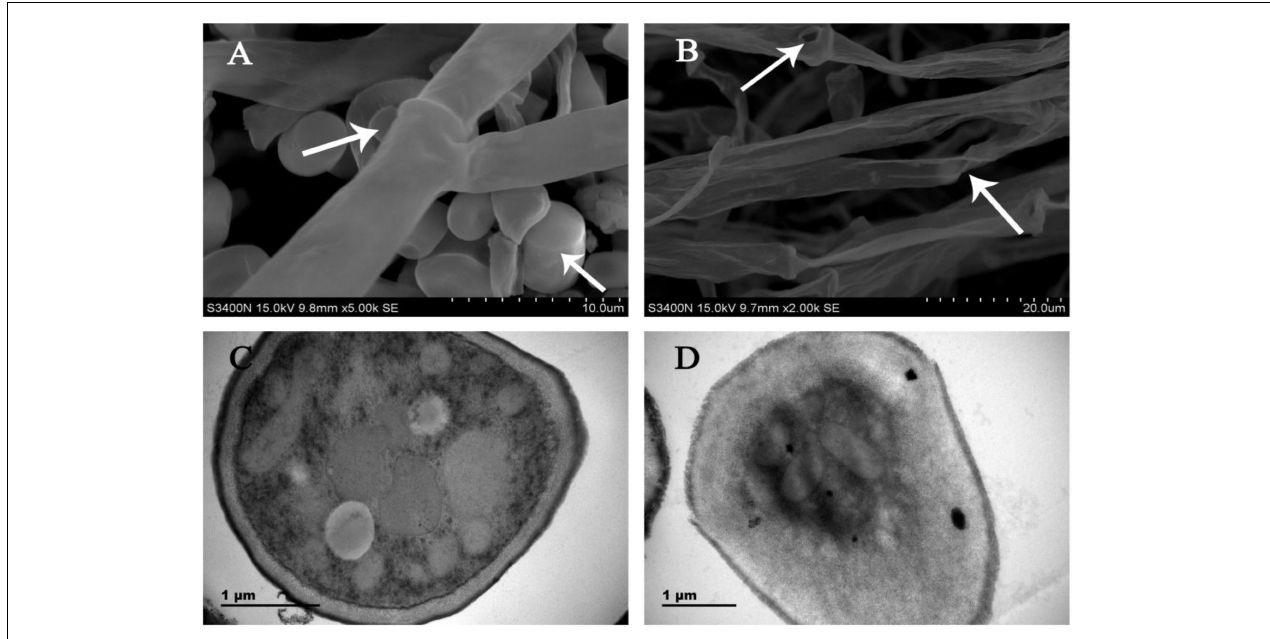
FIGURE 1 | SEM images of (A) untreated control culture of G. citri-aurantii for 4 days; (B) culture after incubation with the CA for 4 days. TEM images of (C) untreated control culture of G. citri-aurantii for 4 days; (D) culture after incubation with the CA for 4 days.